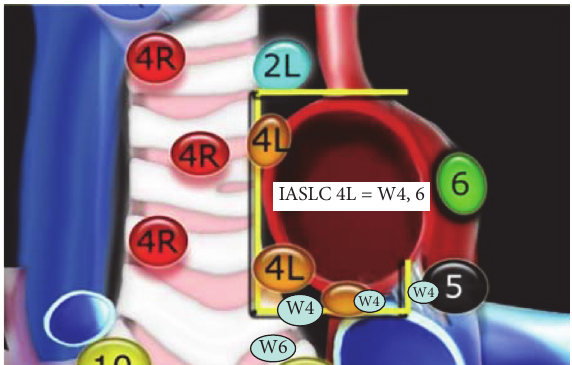
Figure 3: Correlation between IASLC and Wang LN MAP; IASLC 7: subcarinal LN; W2: postcarinal LN; W8: subcarinal LN; W10: sub- subcarinal